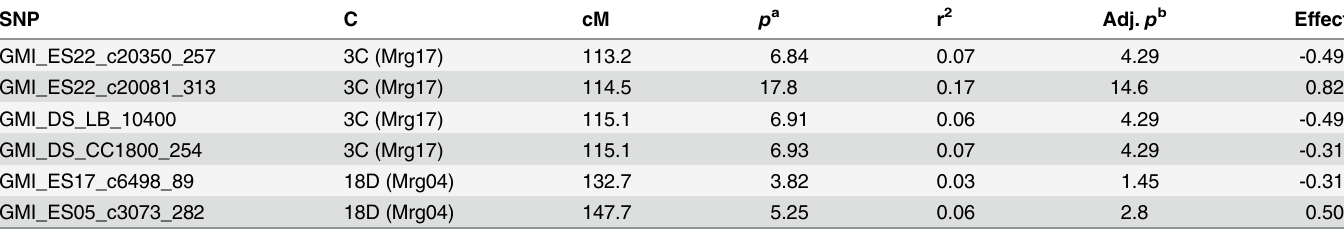
Table 2. SNPs associated with BYDV tolerance in a panel of 428 spring oat lines, chromosomal position, p -values and marker effects. SNP C